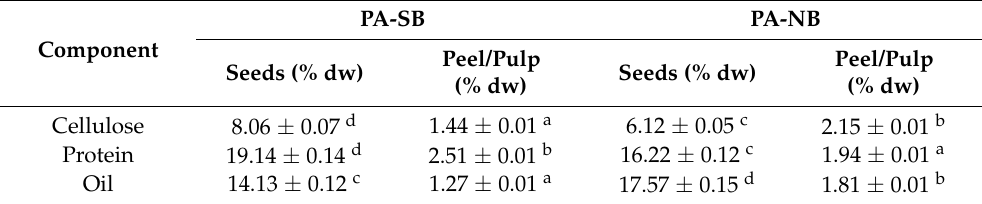
Table 2. Macro component characteristics of fruit structural parts of two P. alkekengi phenotypes (PA-SB and